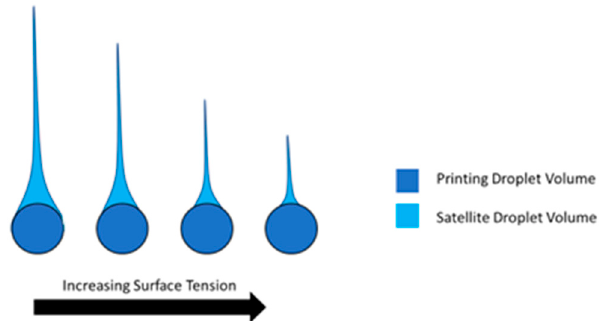
Figure 5. Comparison of droplet volume to satellite volumes with increasing surface tension. As droplets are calculated by their diameter in additive manufacturing, the satellite droplets and tail are not accounted for and cause error. For effective printing, the closer the droplet can realize a spherical shape, the less the error.